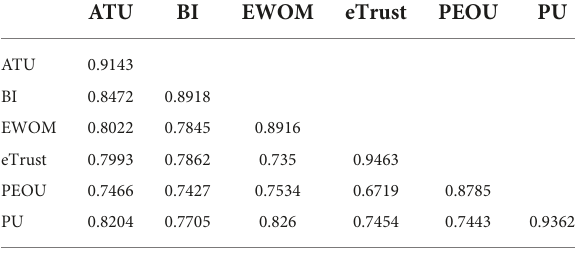
TABLE 3 Discriminant validity test by Fornell and Larcker criterion.